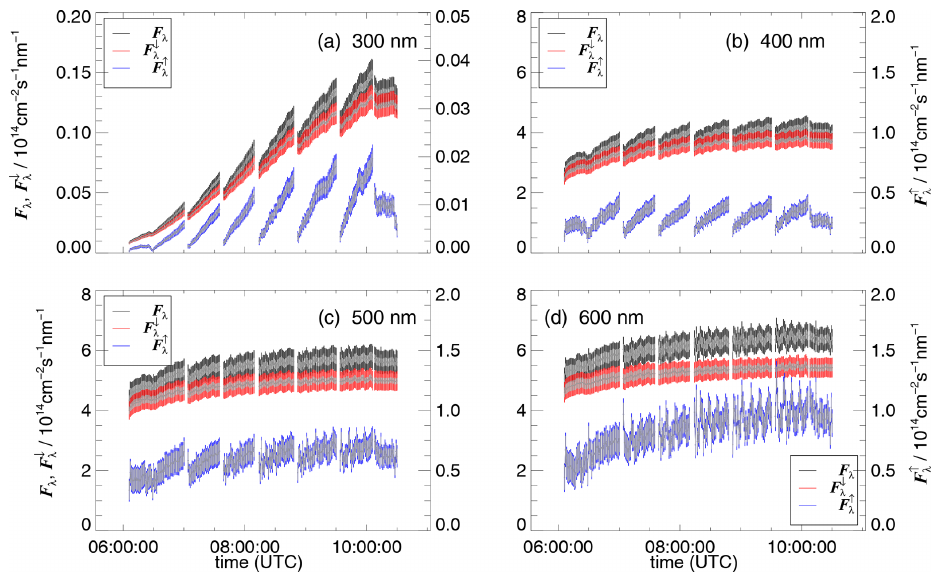
↓ ↑ Figure 16. Total ( F λ ), downward ( F ) and upward ( F ) spectral actinic flux densities of the Zeppelin flight shown in Fig. 15 for the four λ λ selected wavelengths in panels (a) – (d) . The colour-coded error bars correspond to total uncertainties including those from corrections and calibrations (Sect. S7). The overlying grey error bars indicate the uncertainties from the corrections alone. The right-hand y axes refer to the ↑ F . The small, periodic patterns of about 10min were induced by the circular flight λ